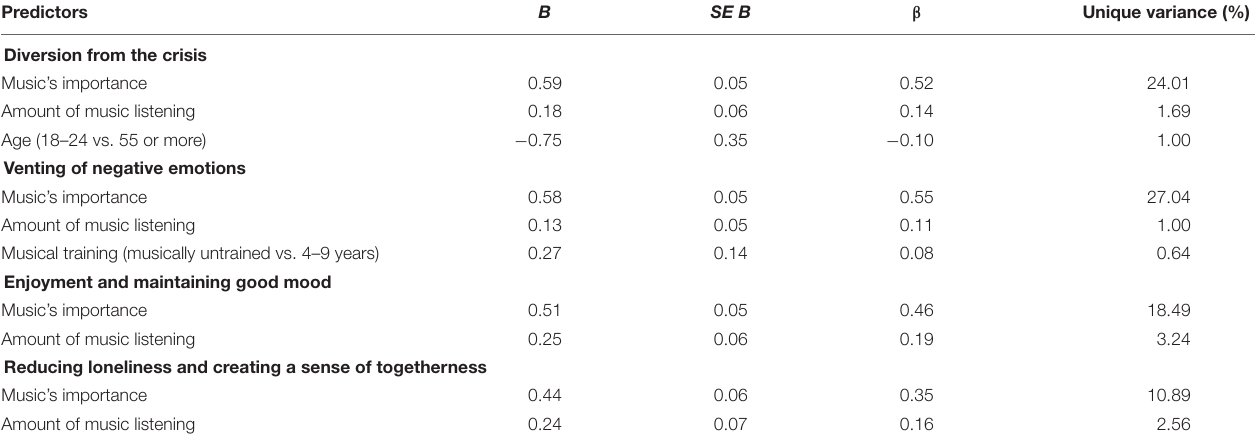
TABLE 5 | Regression models of music efficacy on the affect-regulation